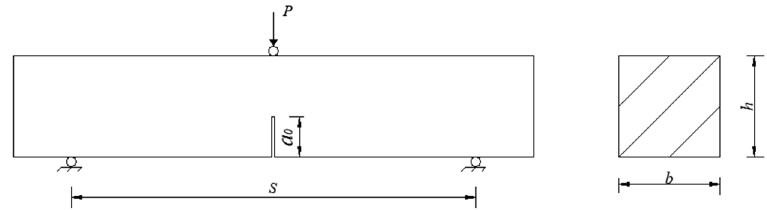
Figure 1. The specimen size and loading mode.